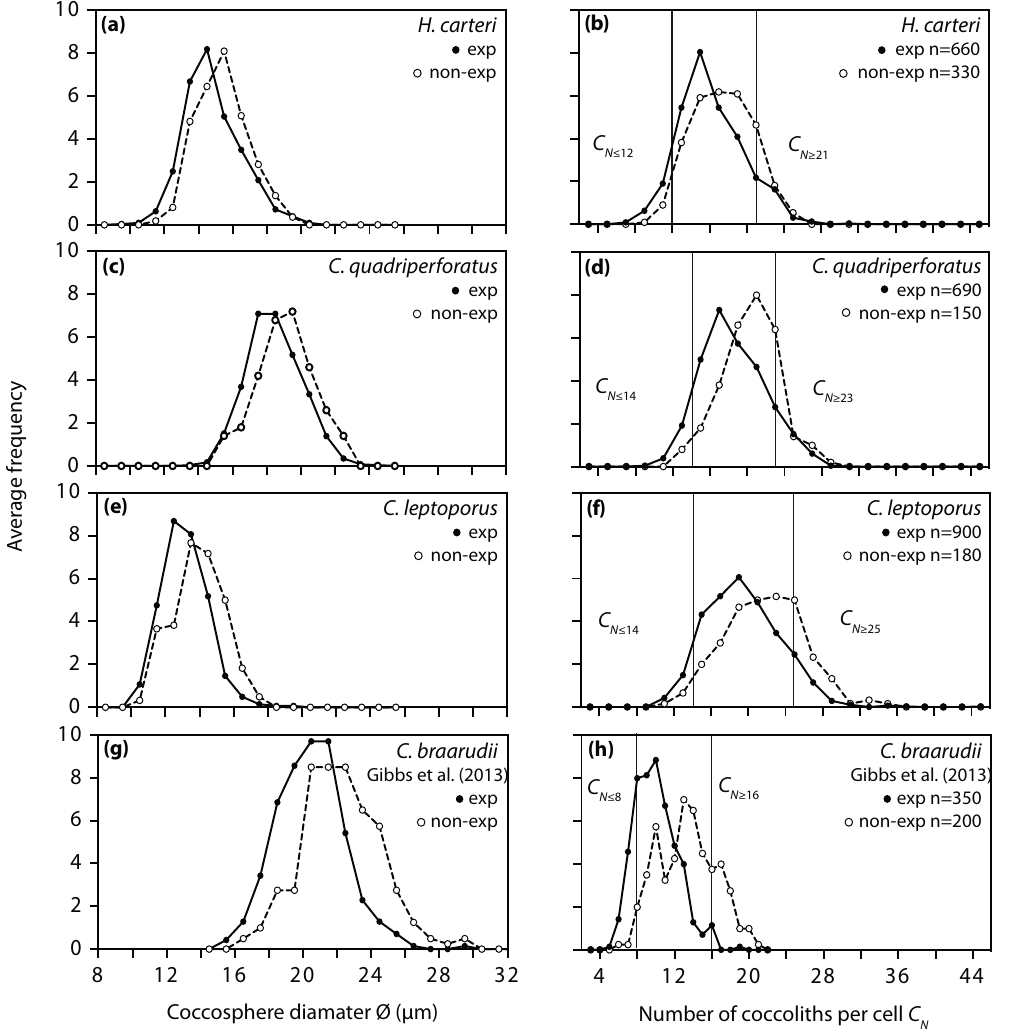
Figure 3. Frequency of coccosphere diameter ( ∅ ) and number of coccoliths per cell ( C N ) for experiment days in exponential growth (solid line) and experiment days no longer in exponential growth (dashed line), averaged across all temperature treatments. (a–f) H. carteri , C. quadriperforatus and C. leptoporus data from this study. (g–h) A reproduction of C. braarudii experiment data from Gibbs et al. (2013) SI Fig. 1e and f for comparison purposes. The lines drawn on C N plots indicate cells that are recently divided and ready-to-divide or non- dividing, based on the 10th and 90th percentiles of the complete species C N data shown in Fig.